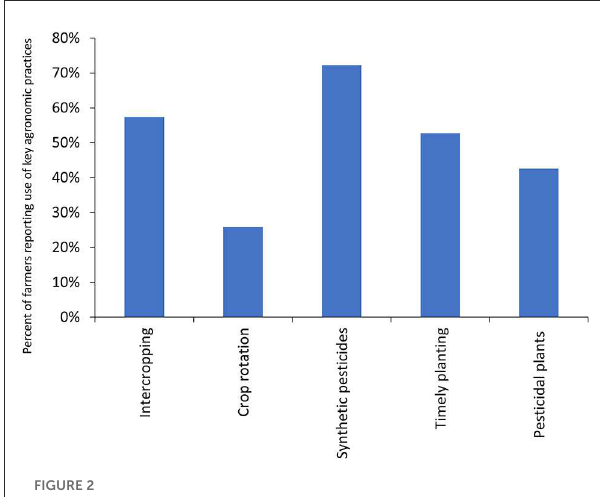
FIGURE2 Proportion of farmers reporting use of key cultural and plant protection practices for insect pest and disease management in